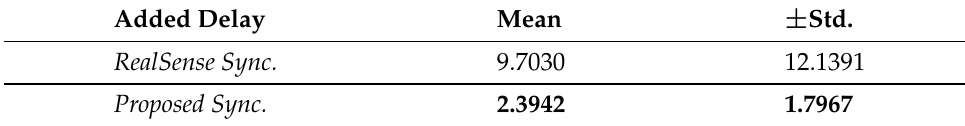
Table 4. Reprojection errors